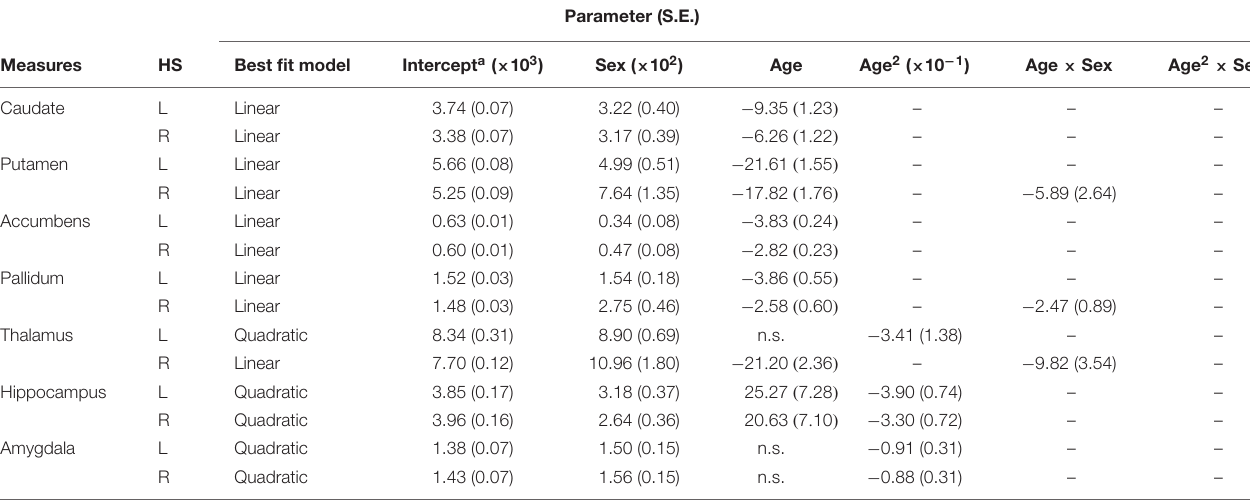
TABLE 2 | Fitting parameters for subcortical volumes versus age within each hemisphere.